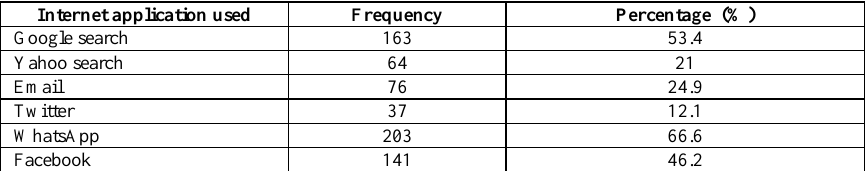
Table 8. Teachers Responses on Internet Application